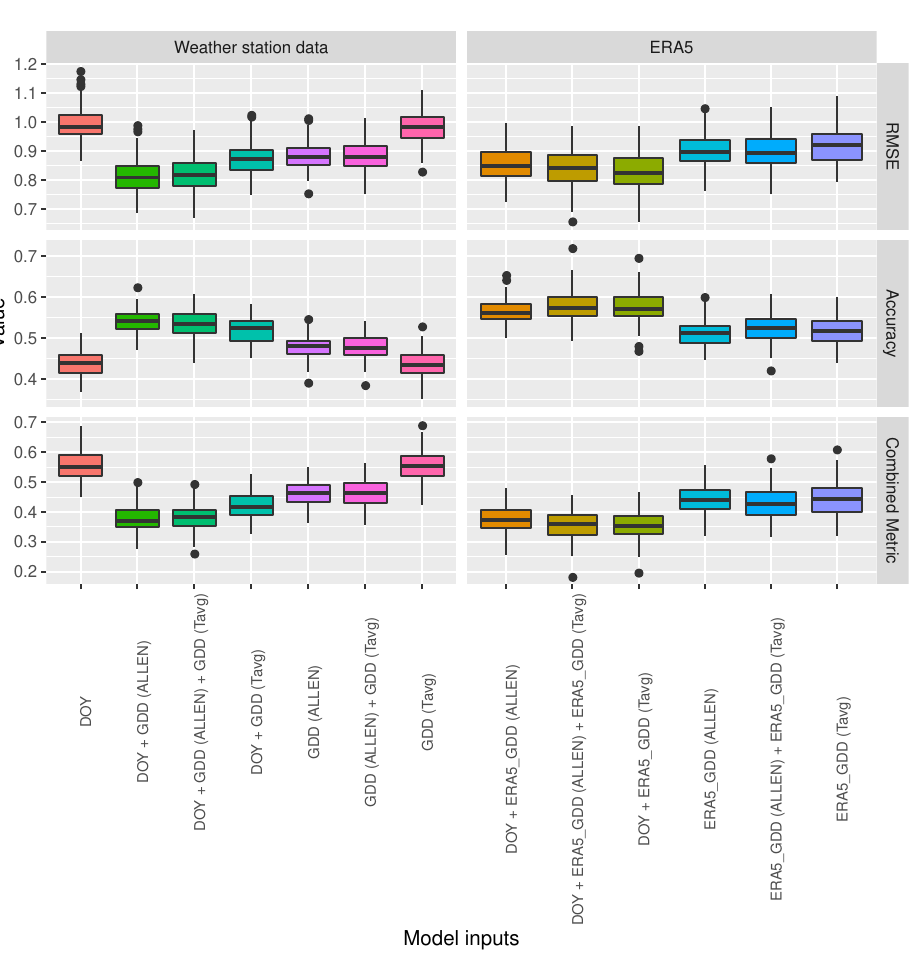
Figure 4. Random forest model performance comparison using different predictors.